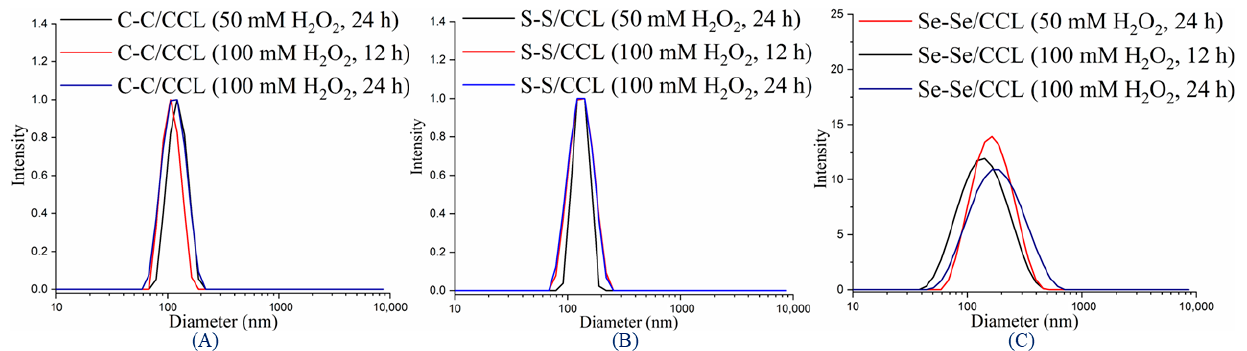
Figure 7. The size change of C–C/S–S/Se–Se CCL micelles with different H 2 O 2 concentrations and treating times ( A – C ). Table 3. Redox-responsive behavior of C–C/S–S/Se–Se CCL micelles with GSH and H 2 O 2 .